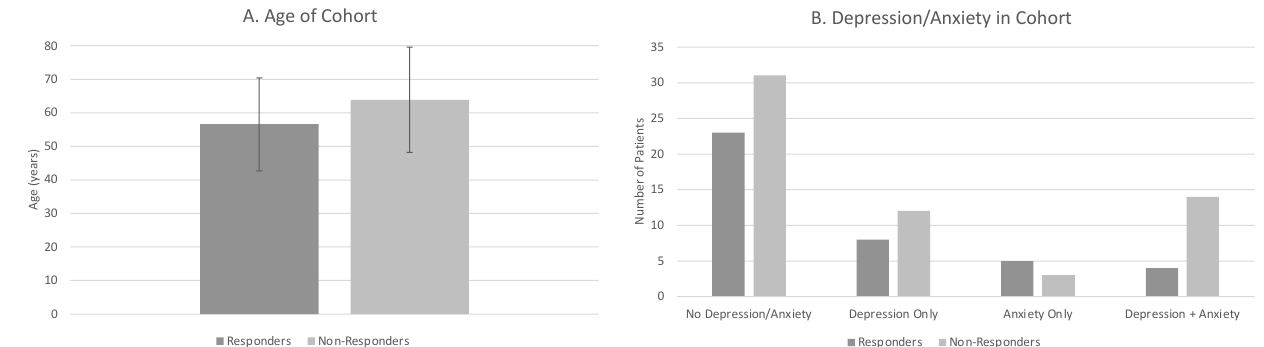
Figure 2. Significant Predictors of Response to Sacroiliac Joint Injections. ( A ) Average age of respon- ders and non-responders. ( B ) Frequency comparisons of depression/anxiety status of responders and non-responders. Table 2. Spine specific risk factors investigated as predictors. The overall multivariate logistical regression explained 24.6% of the variance in the outcome of responsiveness (R 2 = 0.246). The model revealed that a history of depression and anxiety and increased age significantly reduced the odds of responding to injections.